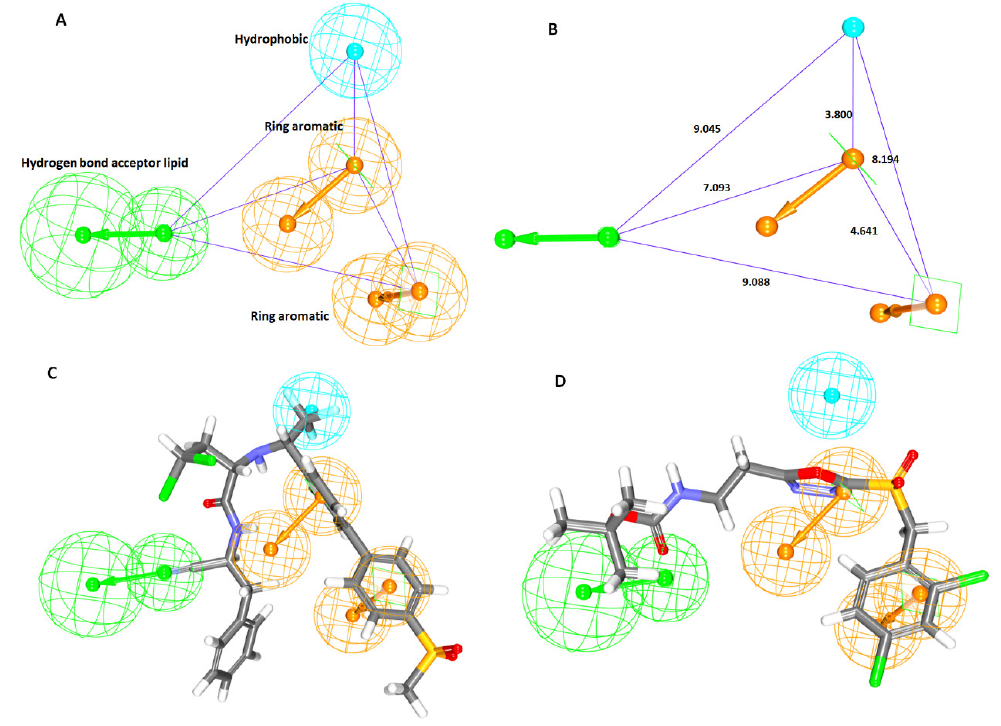
Figure 2. Generated pharmacophore, Hypo 1 with its features and geometry. ( A ) Demonstrates the best pharmacophore model with its features, 1HBL, 1HyP and 2RA. ( B ) Corresponds to the geometry of four features. ( C ) Represents the mapping of best pharmacophore model Hypo1 to the most active compound (IC 50 0.1 nmol/L) in the training set. The compound was seen to align with four features 1HBL, 1HyP and 2RA. ( D ) Refers to the most inactive compound (IC 50 470,000 nmol/L) from the training set. The compound was found to align with only three features, 1HBL and 2RA. Table 2. Different receptor-ligand based pharmacophores and their